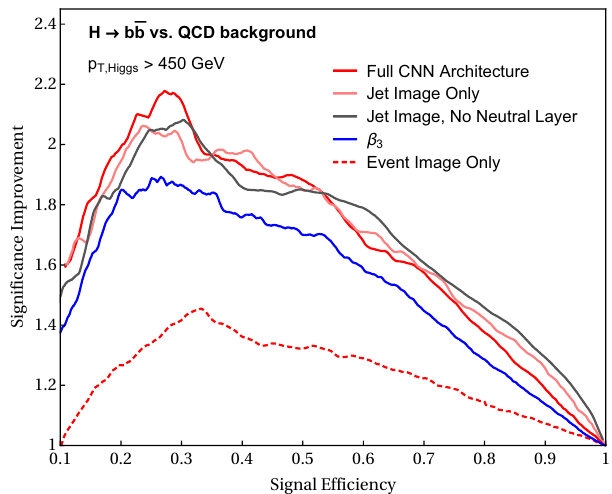
Figure 3 . Signi(cid:12)cance improvement characteristic (SIC) curve for various neural network setups as well as for the single observable (cid:12) 3 proposed in ref.